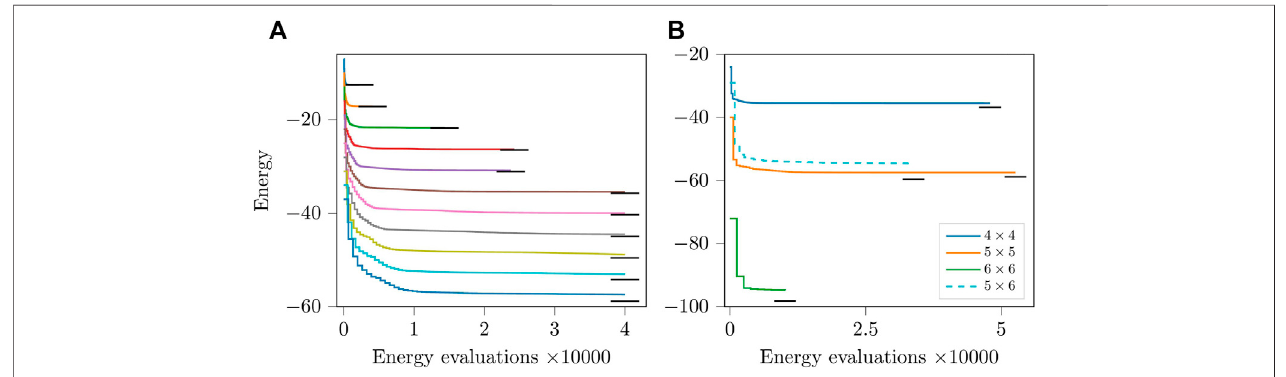
FIGURE 7 | (Colour online) (A) : Energy optimization progress for isotropic ladders with open boundary conditions. The top line is for a lattice with 3 × 2 spins, the secondforonewith4×2spinsandsoonuntilthebottomlinewhichisforalatticewith13×2spins. (B) Energyoptimizationprogressfortwo-dimensionalsquarelattices ofsize4×4and5×5withopenboundaryconditionsand6×6withperiodicboundaryconditions.Thedashedlineisforafrustratedtriangularlatticeofdimensions5×6 with open boundary conditions. The short horizontal black lines represent the ground state energy.